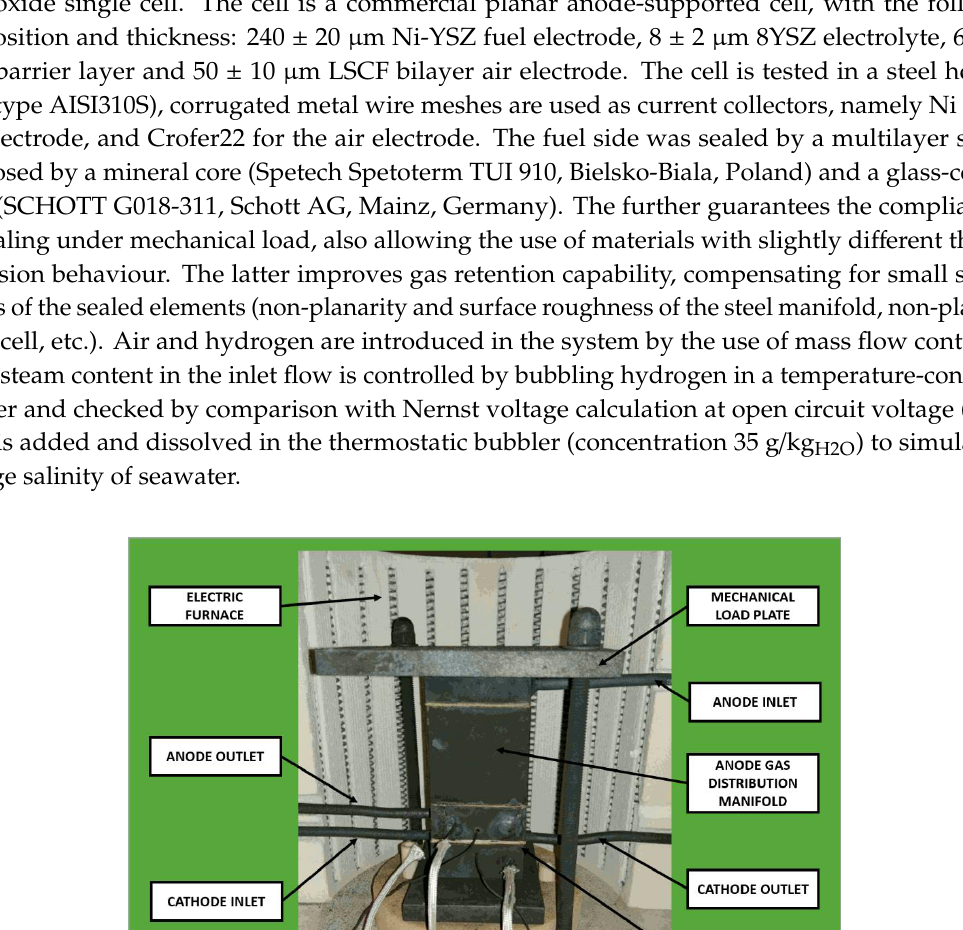
Figure 1. rSOC operation scheme: ( a ) Electrolysis (SOE), ( b ) Fuel cell (SOFC).